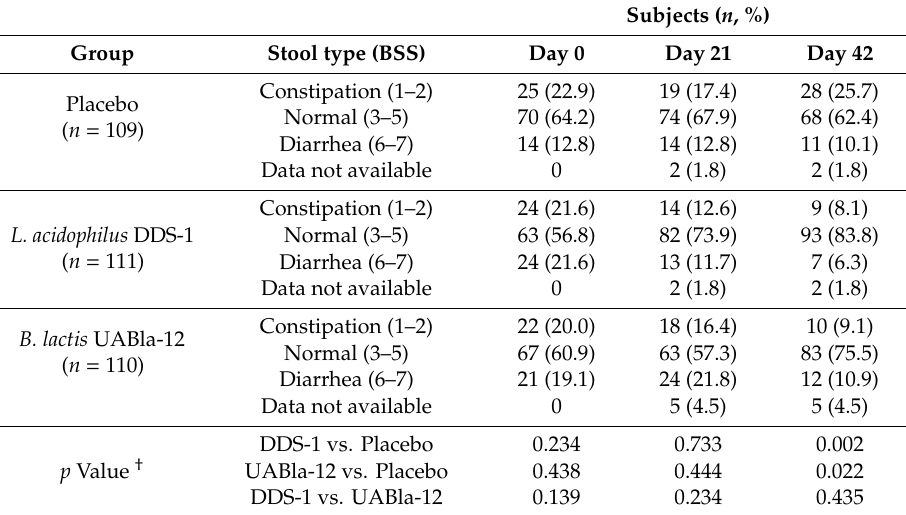
Table 4. Stool consistency profile over the intervention period.